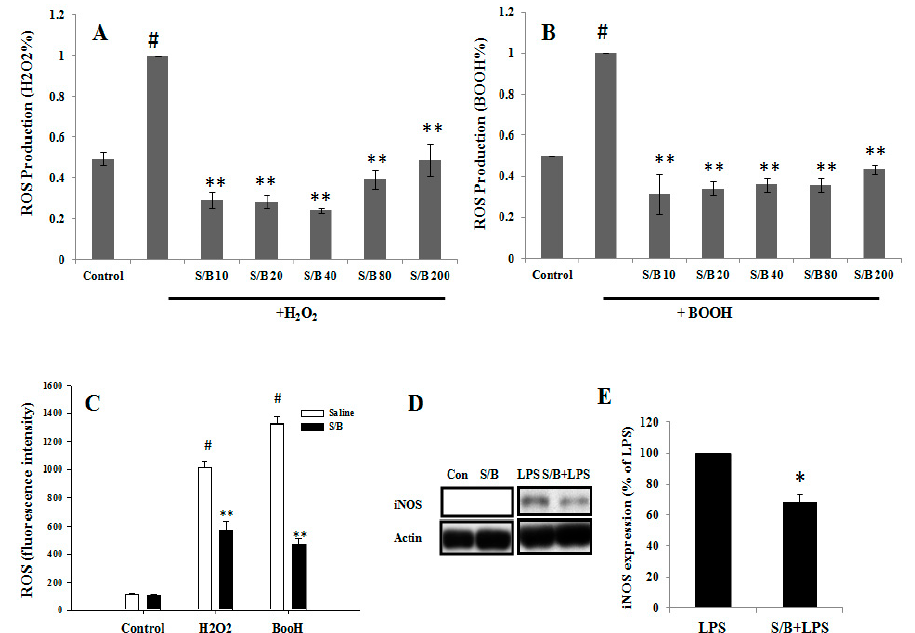
Figure 2. The e ff ects of S / B remedy on H 2 O 2 - and tert-BOOH-induced free radical ROS formation and LPS stimulation in primary CNS cell cultures, wherein ( A ) shows H 2 O 2 (1 mM)-induced ROS in spinal cord neuron-glia cultures and with S / B treatment for 2 h, ( B ) and shows tert-BOOH (0.75 mM)-induced ROS in spinal cord neuron-glial cultures and with S / B remedy treatment for 2 h. The symbols “S / B10”, “S / B20”, “S / B 40”, “S / B 80”, and “S / B 200” refer to the Sb / Bs at 10, 20, 40, 80, and 200 µ g / mL, respectively. ( C ) shows H 2 O 2 (3 mM)- or tert-BOOH (0.75 mM)-induced ROS in microglia cultures and with S / B remedy (80 µ g / mL) treatment. ( D ) shows iNOS expression in Control, S / B-, LPS- or S / B + LPS-treated microglia. ( E ) shows quantitative results of iNOS expression in LPS- or S / B + LPS-treated microglia from three independent experiments. The symbols “#”, “*” and “**” indicate statistical significance by one-way ANOVA and Bonferroni t-test at p < 0.01 (H 2 O 2 or tert-BOOH treated cells vs. control), p < 0.01 (peroxide plus S / B vs. peroxide alone) and p < 0.05 (LPS plus Sb / Bs vs LPS alone), respectively.